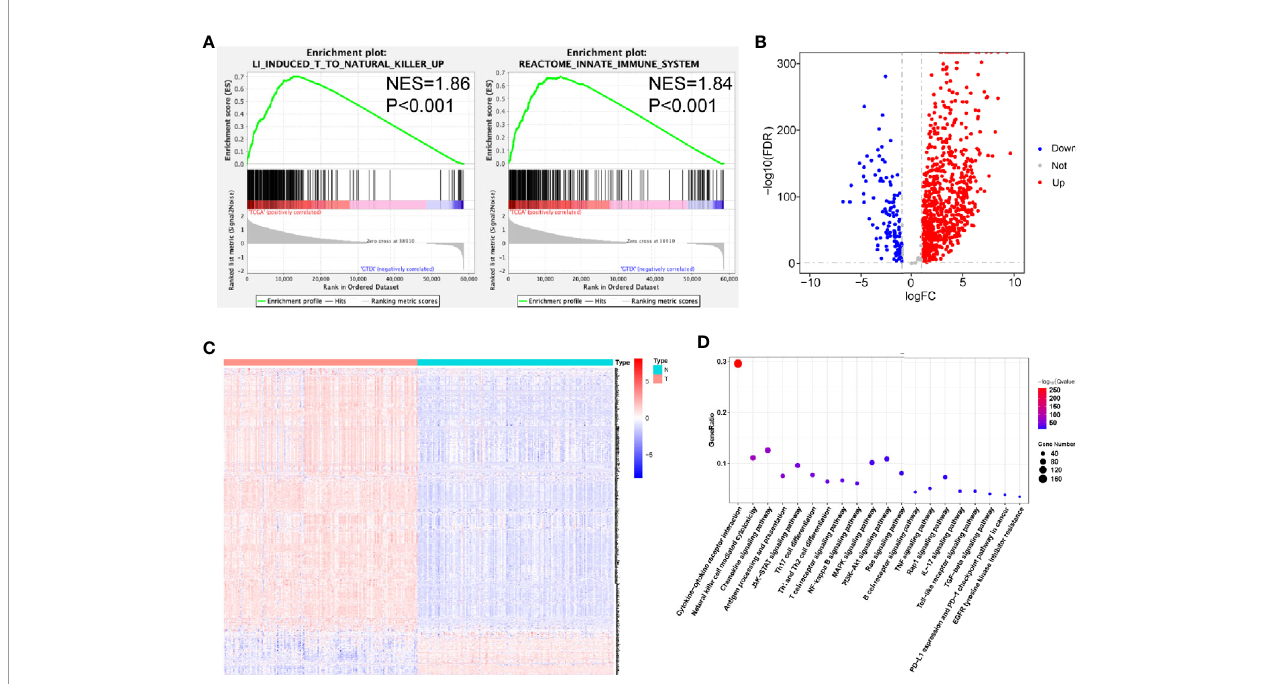
FIGURE 1 | Relationships between pancreatic ductal adenocarcinoma (PDAC) and normal pancreatic tissues. (A) Signi fi cant enrichment of immune-related pathways in tissues from patients with PDAC, compared with normal pancreatic tissues. NES, normalized enrichment score. (B) Volcano plot of 871 metabolism- related genes differentially expressed in PDAC and normal pancreatic samples. (C) Heatmap showing the expression of IRGs in each sample. (D) Functional analysis of 838 metabolism-related